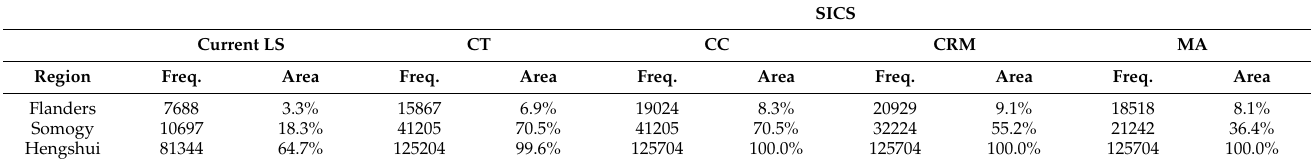
Table 4. Frequencies (number of pixels) and area (% of total region area) for S2-classified areas per test site under current LS and various SICS